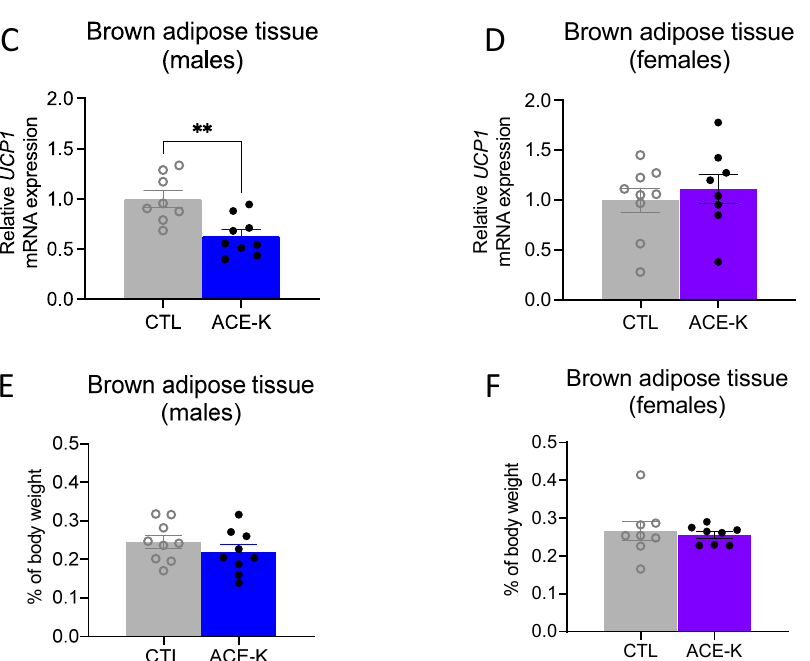
Figure 4. Effects of early life ACE-K consumption on adult brown adipose tissue (BAT) thermogenic markers. Early life ACE-K consumption at the ADI (15 mg/kg) decreased the relative mRNA expression of BMP8B and UCP1 in male rats ( A , C ) relative to controls but had no effect in female rats ( B , D ). These effects were observed in the absence of differences in BAT percentage of total body weight for both sexes ( E , F ). Data are represented as mean ± SEM, ** p < 0.01, **** p < 0.0001; ACE-K: acesulfame potassium; CTL, control.